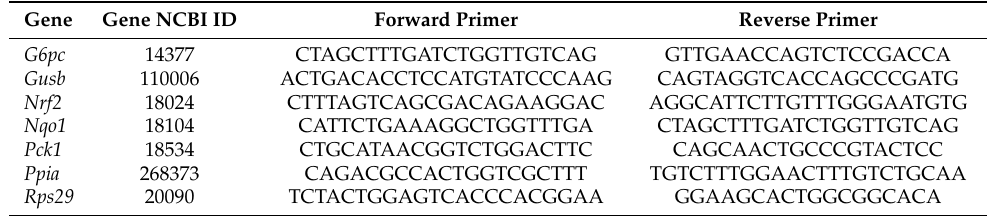
Table 1. Primers used for real-time PCR.